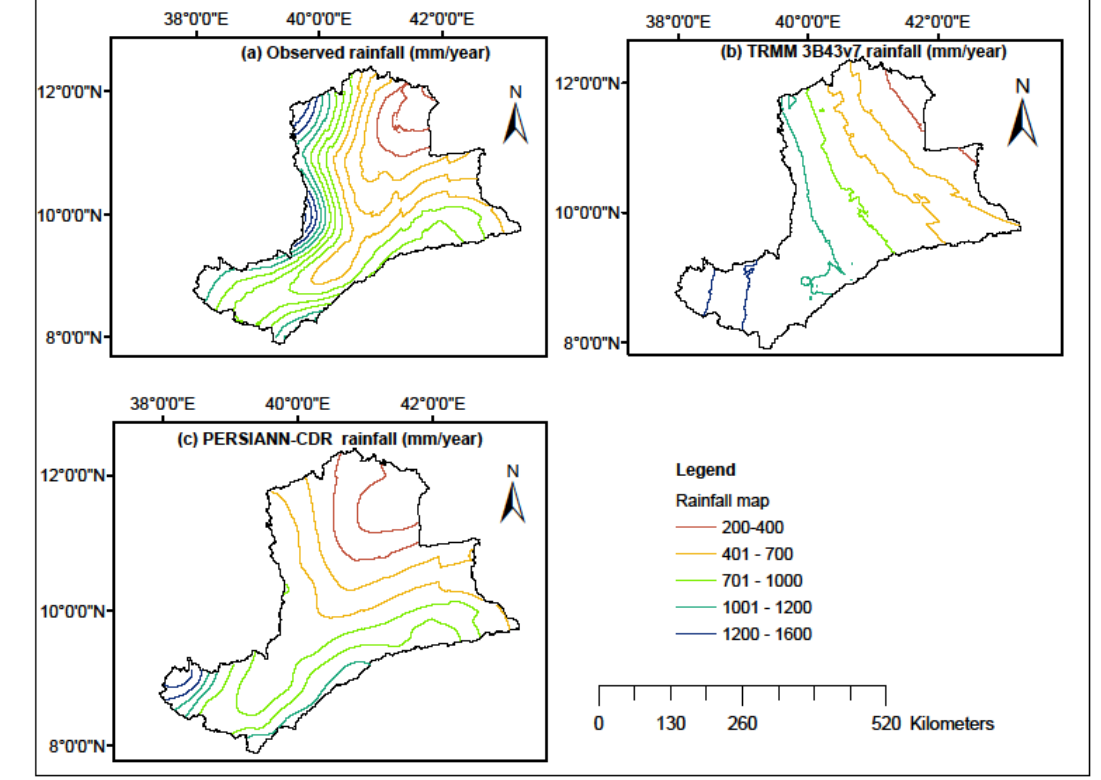
Figure 3. ( a – c ) Isohyetal rainfall map using kriging of mean multiannual rainfall records generated with different data sources.